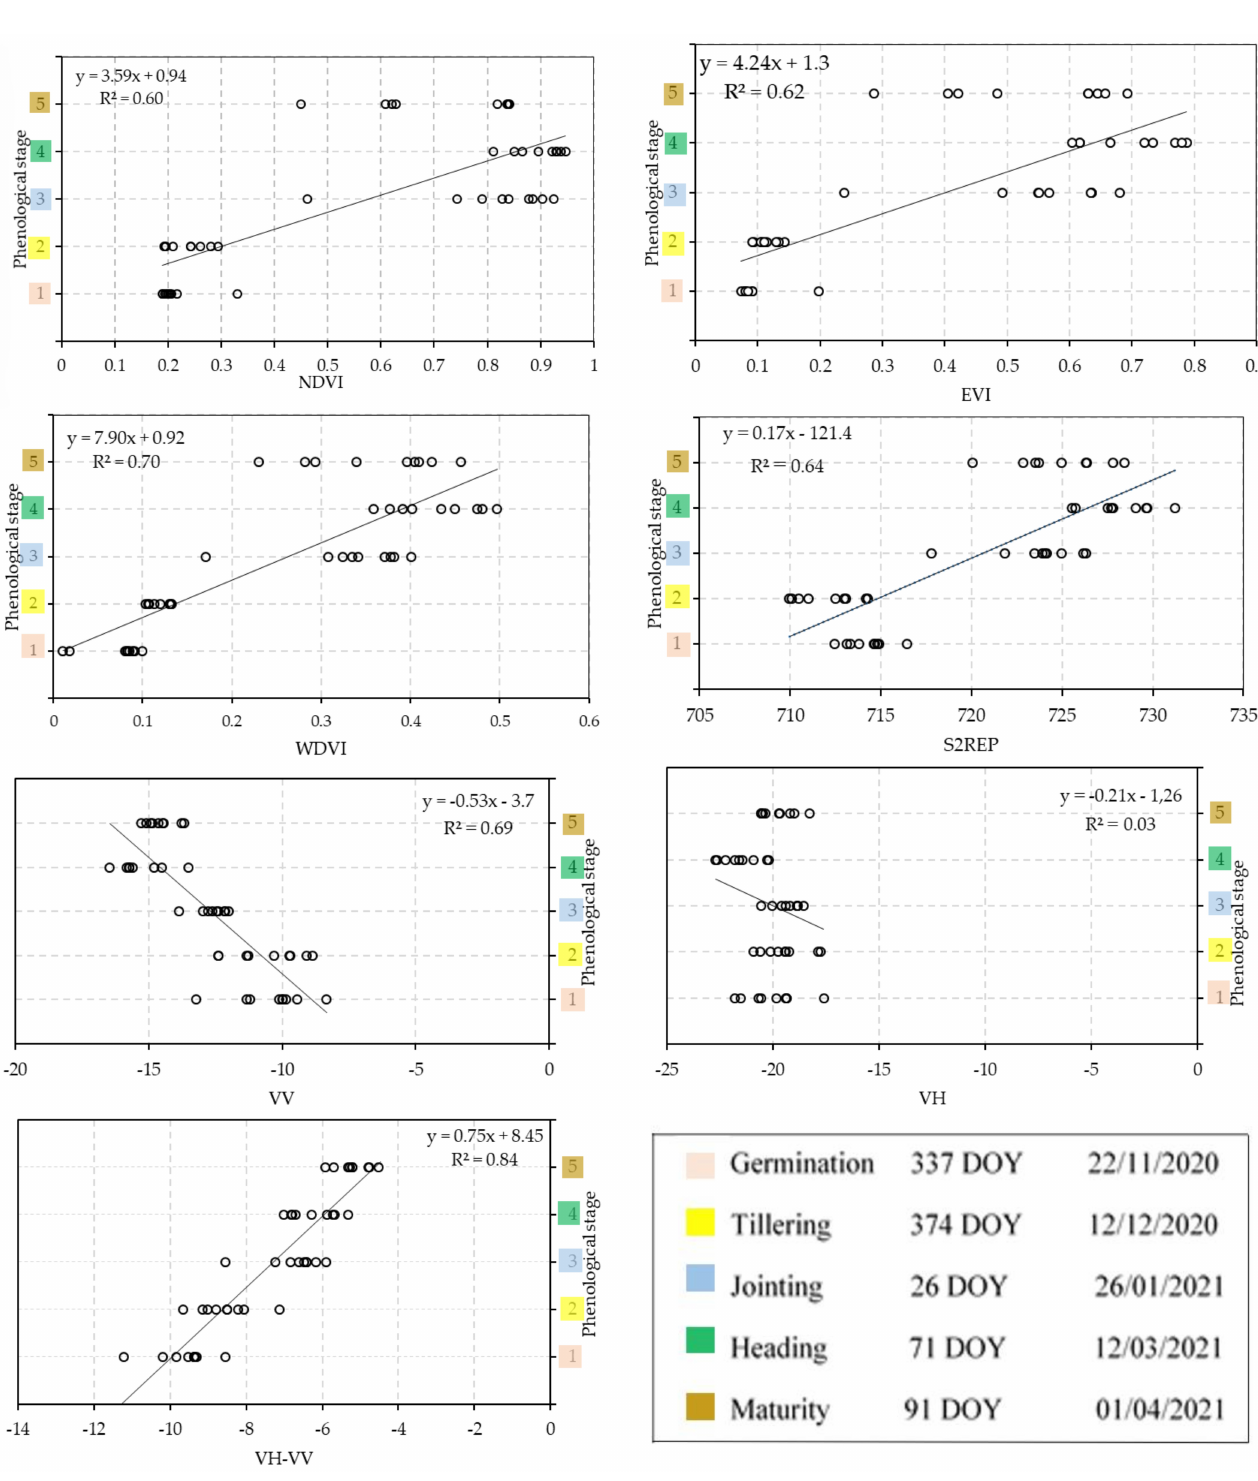
Figure 10. The correlations between phenological stages and optical / SAR remote sensing